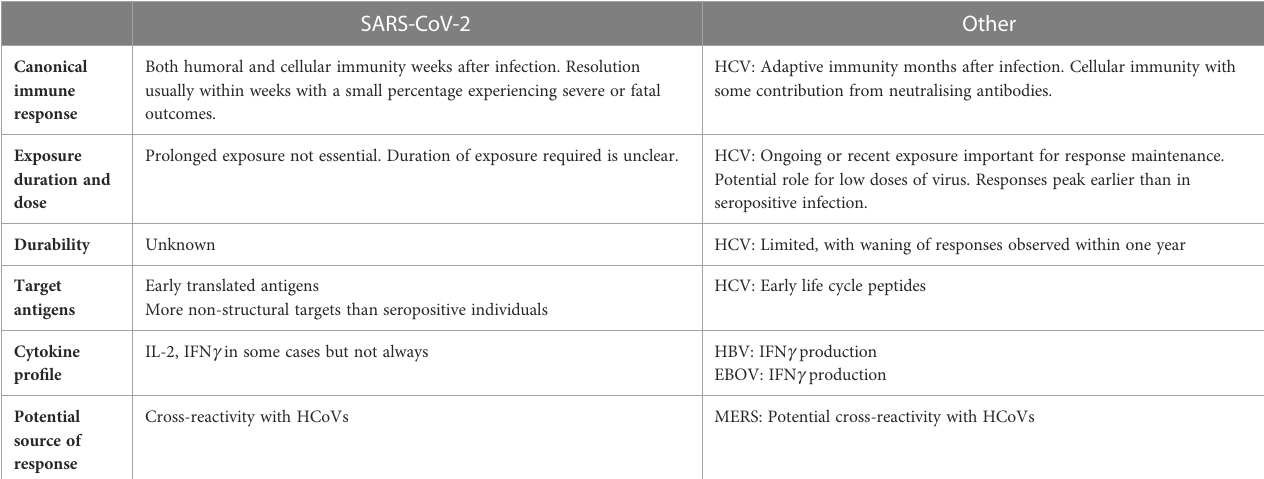
TABLE 1 Summary of ESN fi ndings for SARS-CoV-2 and other viruses. SARS-CoV-2 Other Canonical Both humoral and cellular immunity weeks after infection. Resolution immune usually within weeks with a small percentage experiencing severe or fatal response outcomes. Exposure duration and